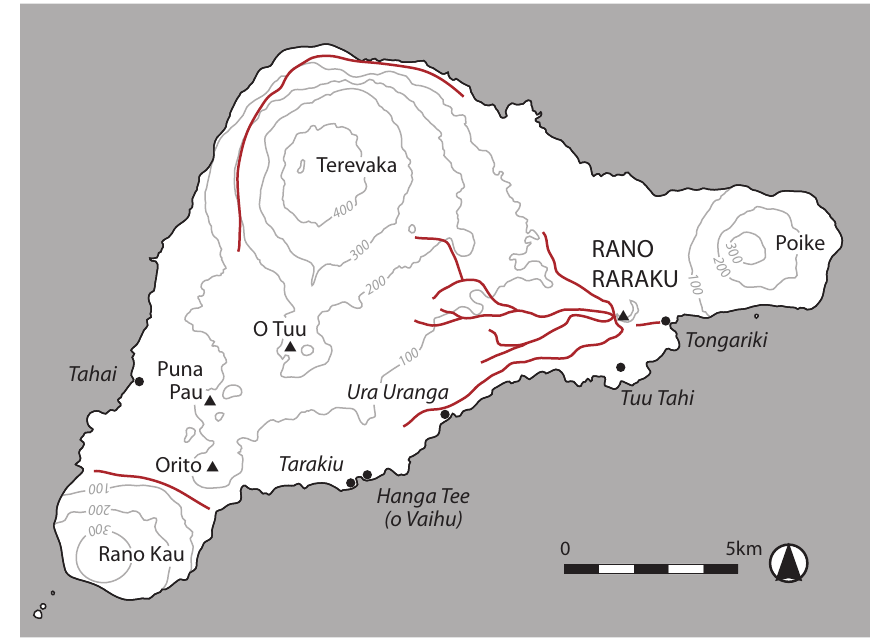
Figure 3 Map of Rapa Nui showing the sites mentioned in the text and the statue roads (in red).